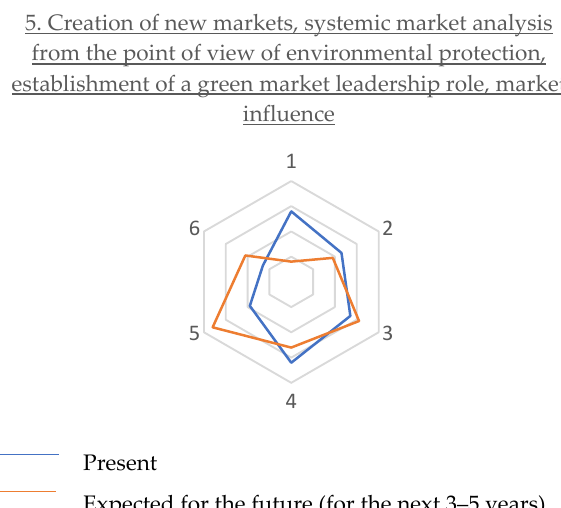
Figure 8. The spider web diagram of the scores given by the respondents at Stage 5 of becoming sustainable. Source: edited by authors.